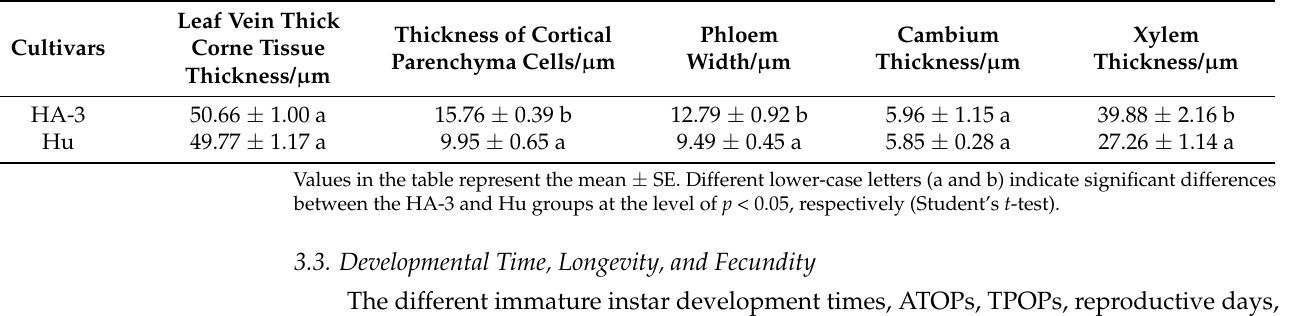
The different immature instar development times, ATOPs, TPOPs, reproductive days, longevity, and fecundity for SAA G1-G10, for the HA-3 and Hu cultivars, are